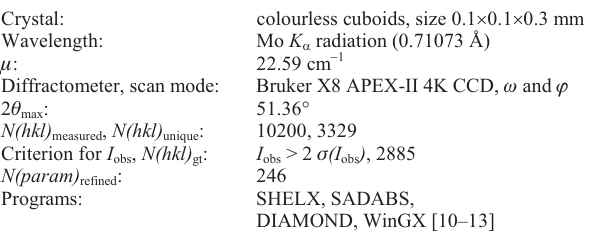
Table 1. Data collection and